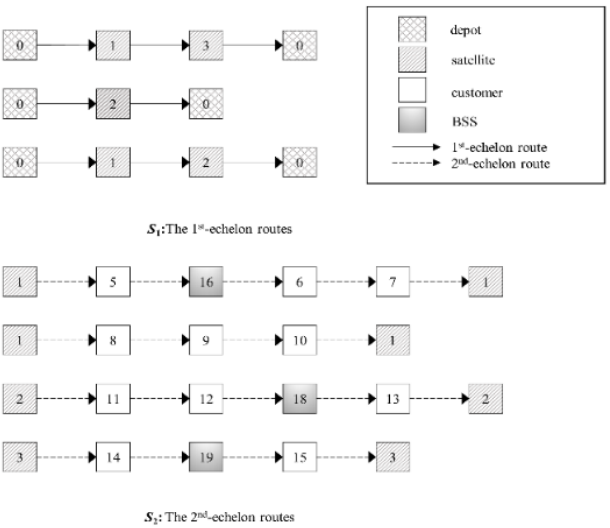
Figure 2. Representation example of a solution of the 2E-EVRPTW-BSS.